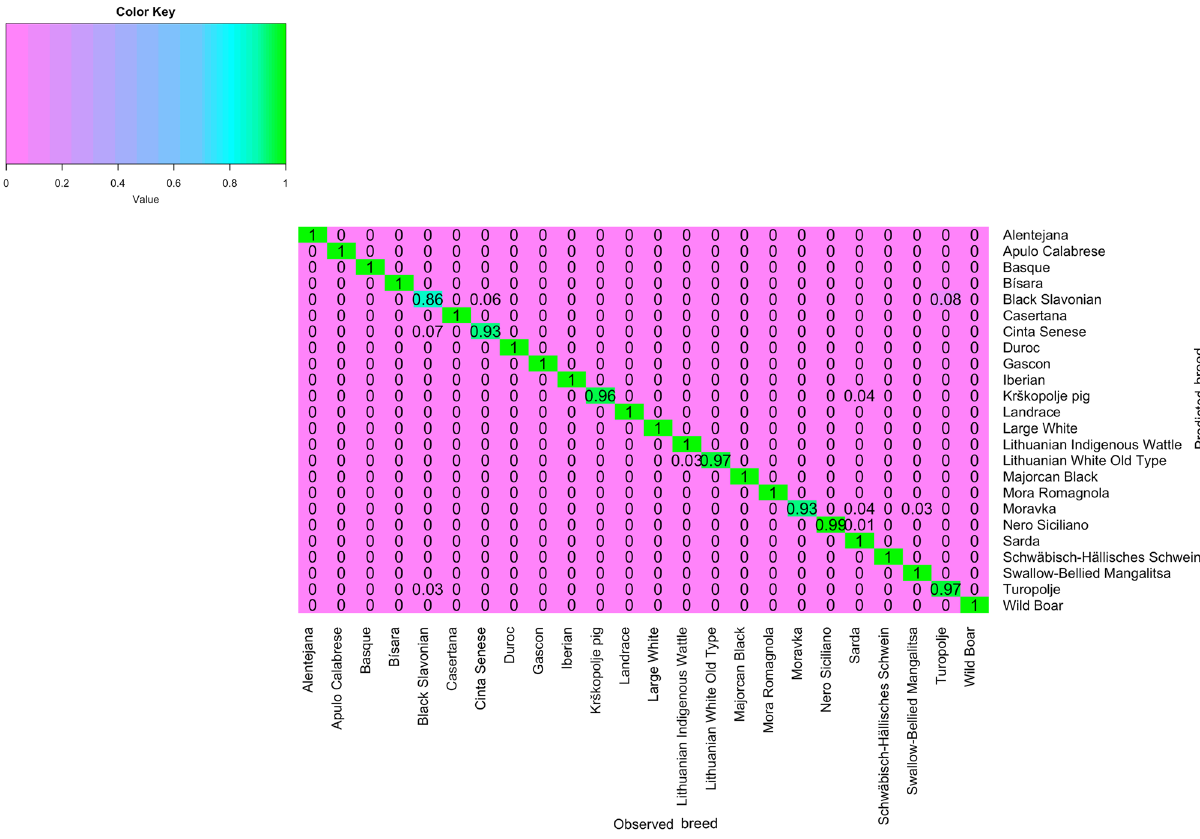
Figure 3. Heatmap of the DAPC assignment in the semi-supervised scenario with percentage of correct assignment per breed (in a scale of 0–1). Heatmap was constructed using the R 36 package gplots 37 and the function heatmap.2 .